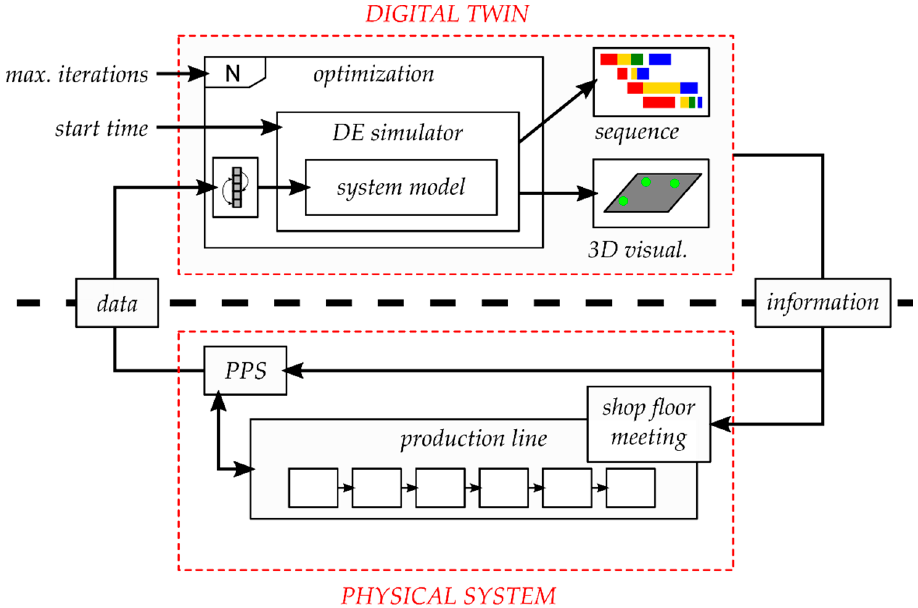
Figure 2. Principal procedure of the digital twin and data/information exchange with the physical Figure system.